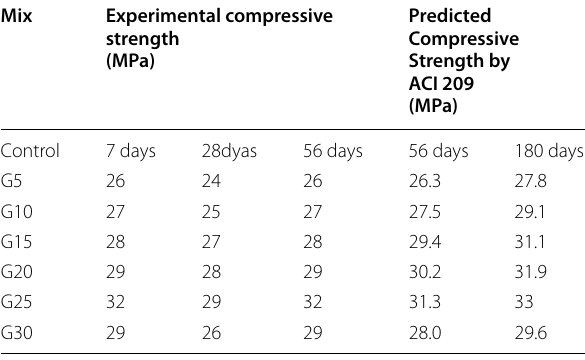
Table 5 Concrete mixed proportion.